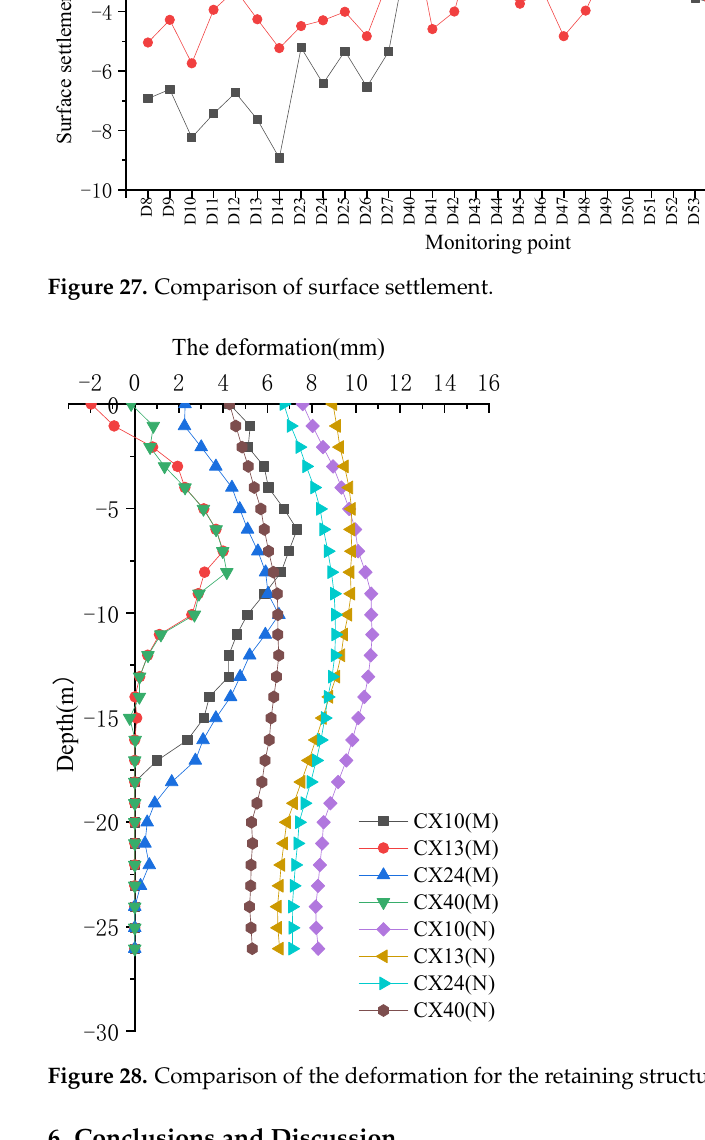
Figure 28. Comparison of the deformation for the retaining structure.